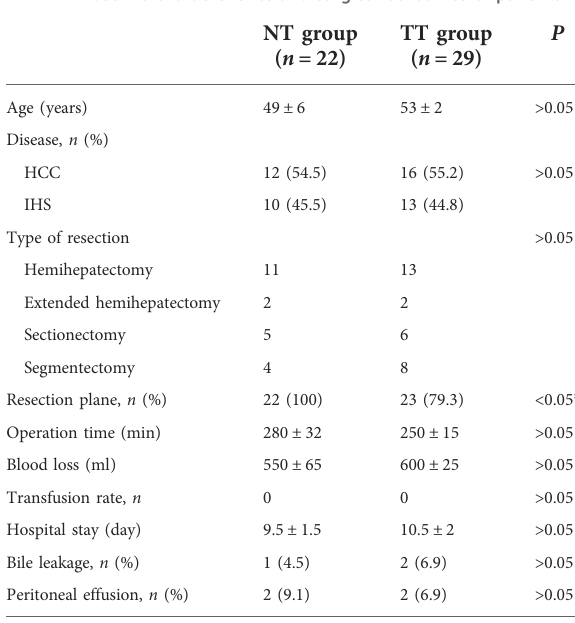
TABLE 1 Baseline characteristics and surgical outcomes of